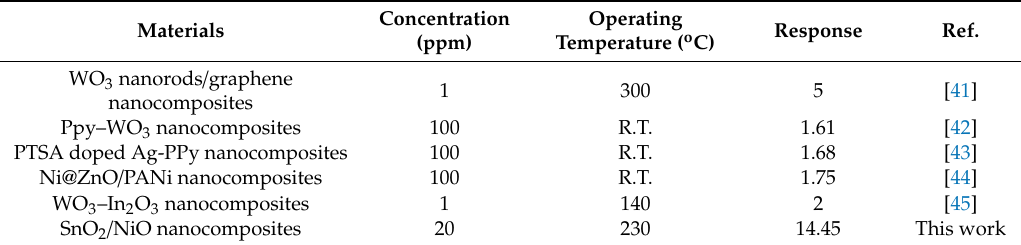
Table 1. Comparison of di ff erent NO 2